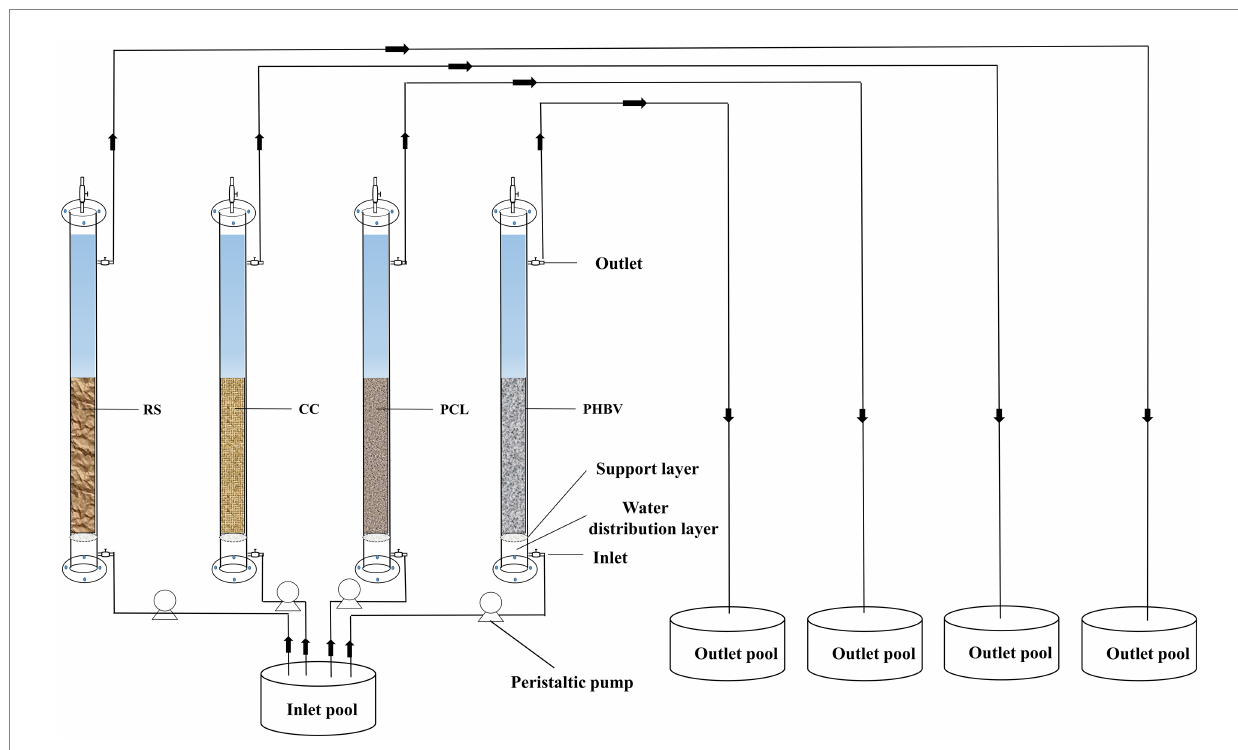
FIGURE 1 Schematic of the denitrification biofilm